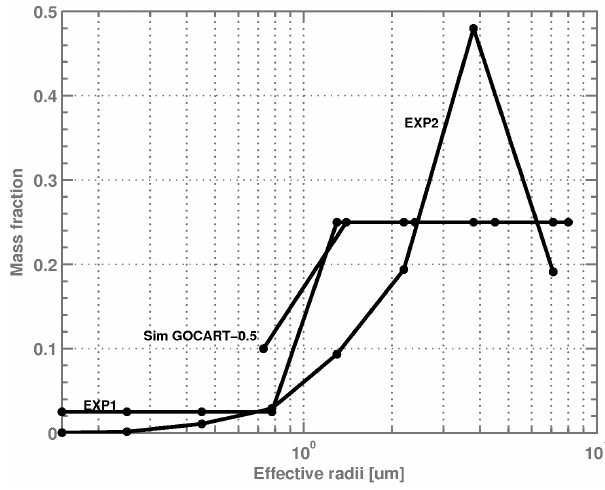
Figure 13. Dust bins mass fraction for EXP1, EXP2 and